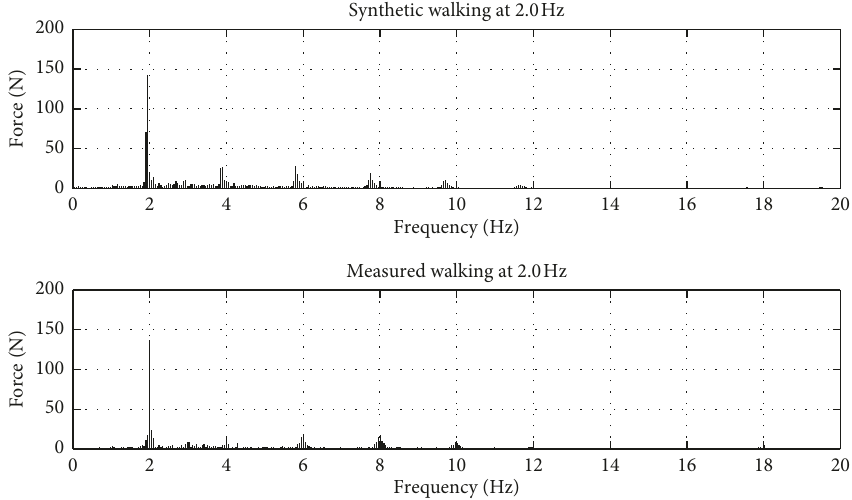
Figure 15: Synthetic continuous walking and measured walking at 2.0Hz.